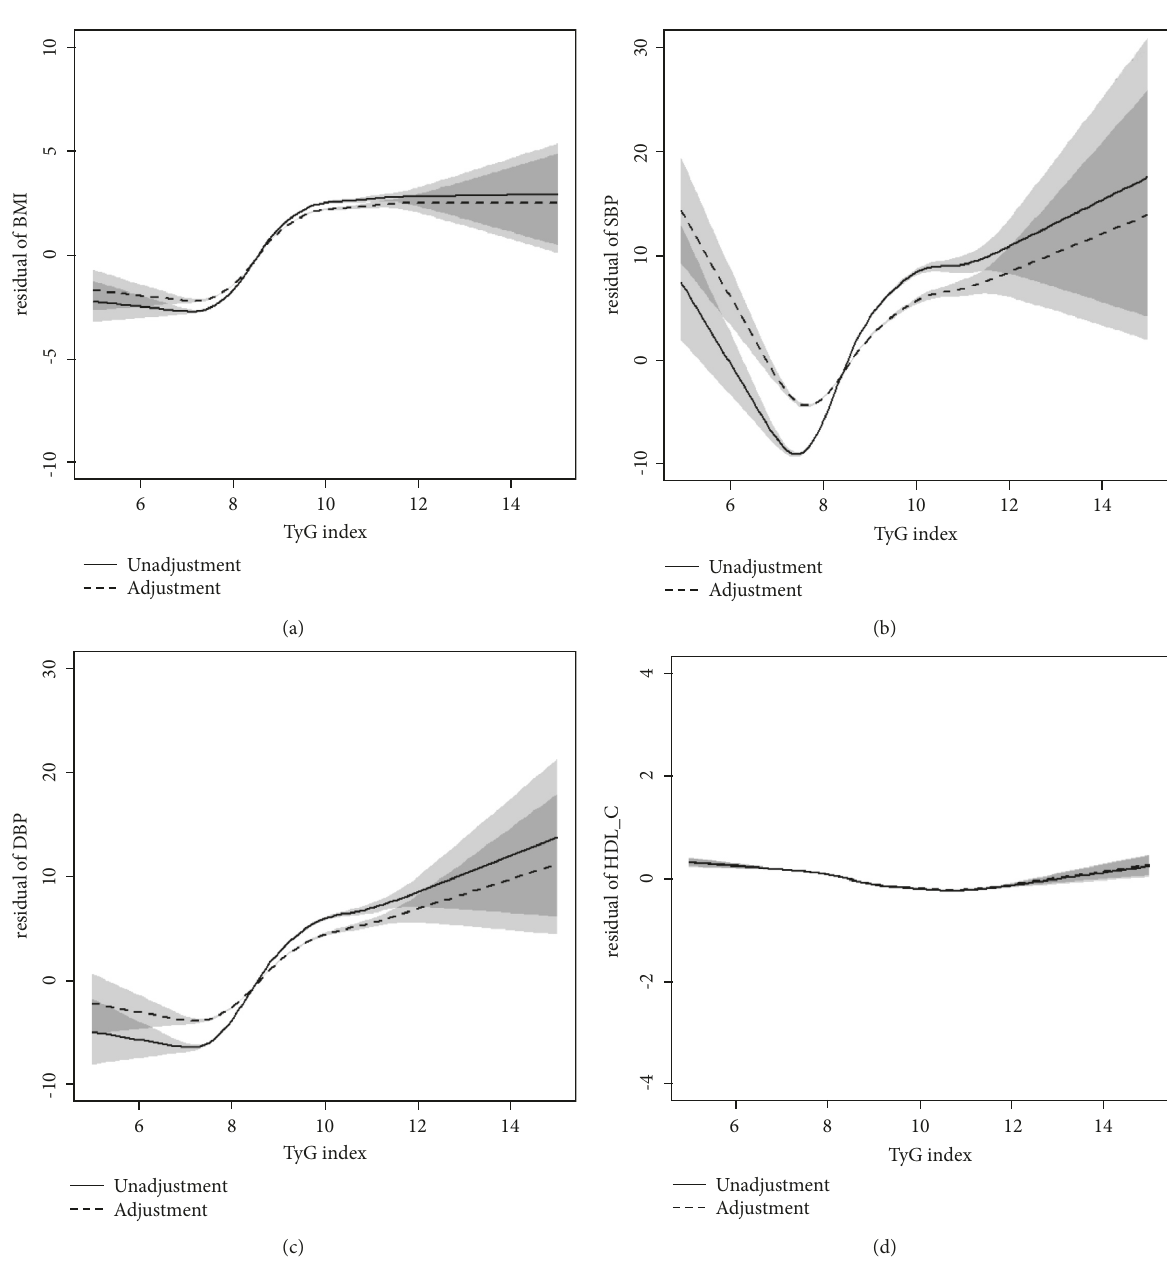
Figure 1: Relationship between TyG index and MS components. The X -axis represents the TyG index; the Y -axis shows the residual of the MS components. Solid line, unadjusted; dotted line: adjusted for age, sex, BMI, smoking, drinking, SBP, DBP, TC, HDL-C, LDL-C, TG, FBG, and eGFR (when used as the longitudinal coordinate, it was not adjusted). (a) Correlation of BMI with TyG index. (b) Correlation of SBP with TyG index. (c) Correlation of DBP with TyG index. (d) Correlation of HDL-C with TyG index. TyG index was calculated using the FBG and TG indices, and thus their relationship with FBG and TG was not discussed further. TyG, triglyceride-glucose; BMI, body mass index; SBP, systolic blood pressure; DBP, diastolic blood pressure; HDL-C, high-density lipoprotein